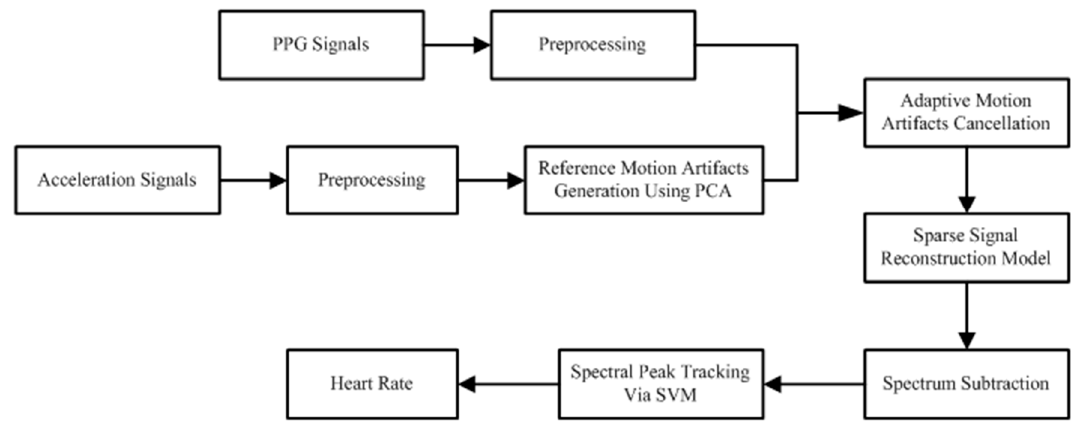
Figure 1. Flowchart of the developed system.